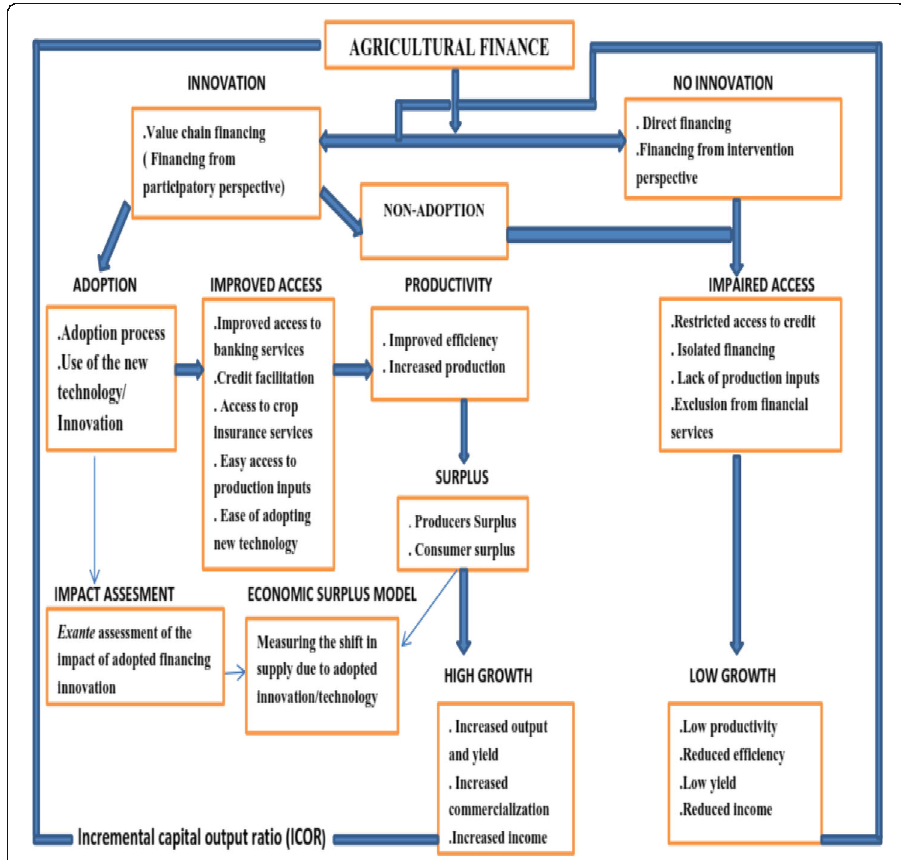
Fig. 2 Conceptual framework of VCF impact on plantain production. Source: The Author